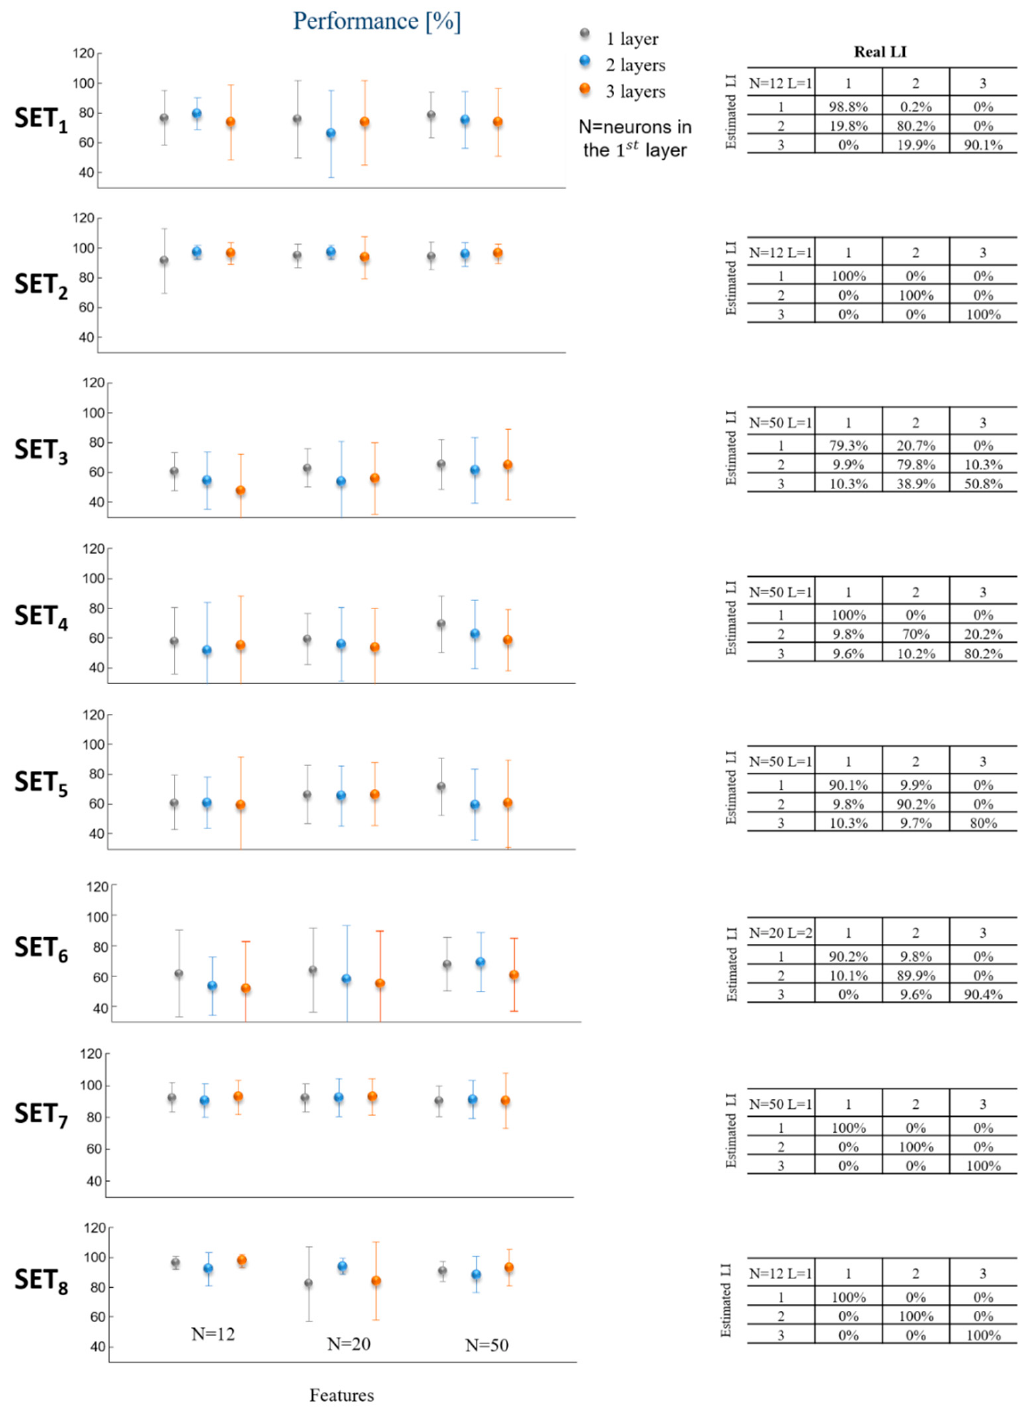
Figure 3. ANNs performance. The performance are reported on the basis of the di ff erent training sets (SET i , i = 1, ... , 8) and the nine di ff erent architectures (see Section 2.7 for details). The best mean confusion matrix was reported for each SET i .